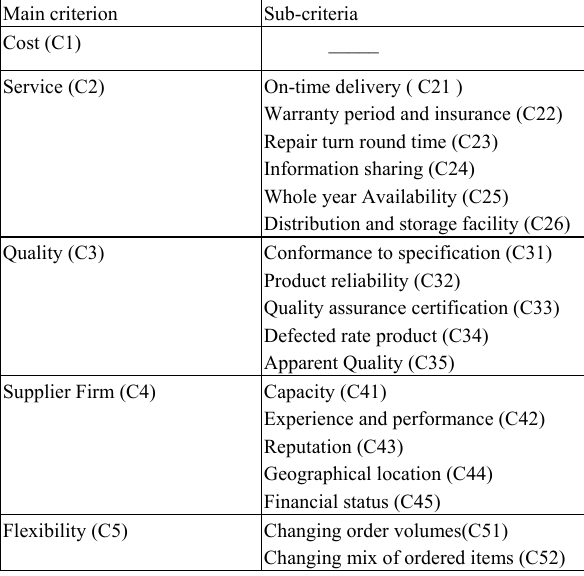
Table 1. Criteria taken into account to select the best supplier